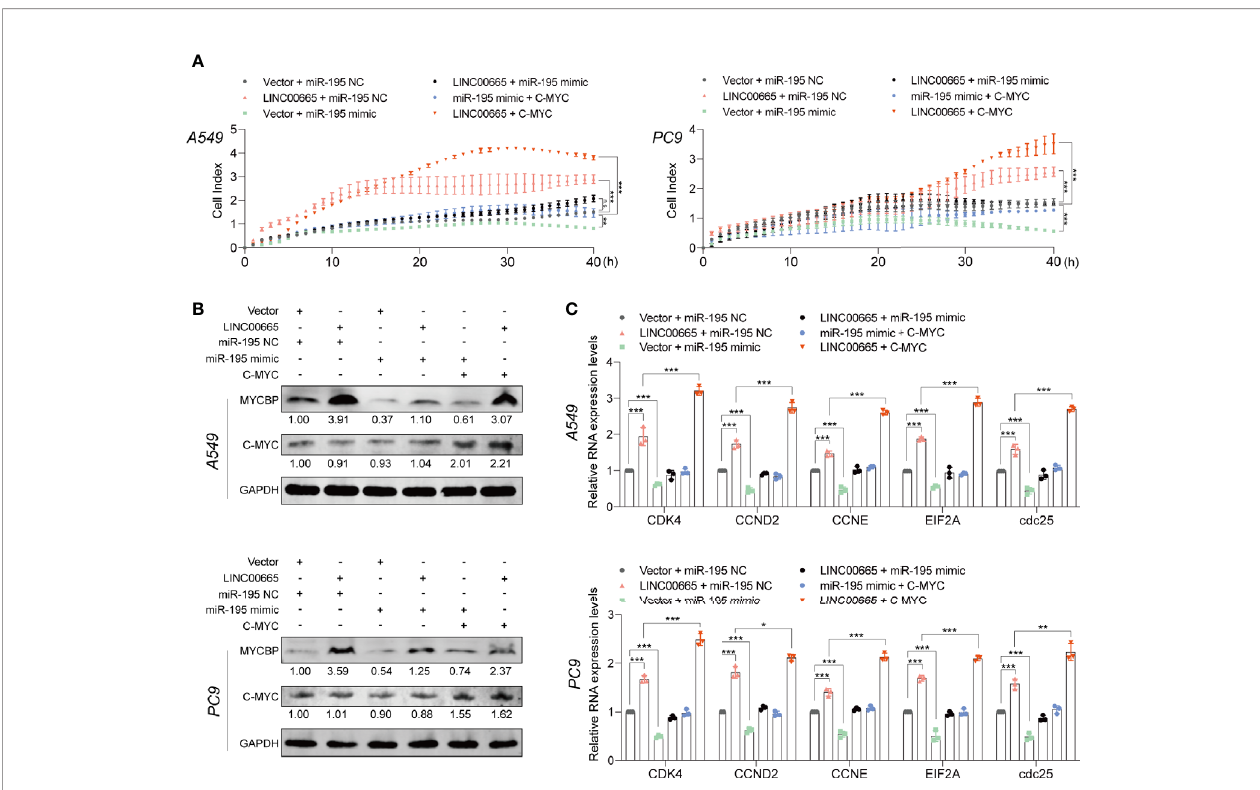
FIGURE 6 | miR-195-5p reverses the tumor-promoted roles of LINC00665 or c-Myc in A549 and PC9 cells. (A) RTCA assay performed in A549 and PC9 cells after LINC00665 knockdown or overexpression and cotransfection with miR-195-5p inhibitor or mimics. (B) MYCBP and C-Myc protein levels measured in A549 and PC9 cells after LINC00665 knockdown or overexpression and cotransfection with miR-195-5p inhibitor or mimic or C-Myc. (C) C-Myc downstream mRNA levels measured with q-RT-PCR in A549 and PC9 cells after LINC00665 knockdown or overexpression and cotransfection with miR-195-5p inhibitor or mimic or C-Myc. *p < 0.05; **p < 0.01; ***p < 0.001. n.s., no signi fi